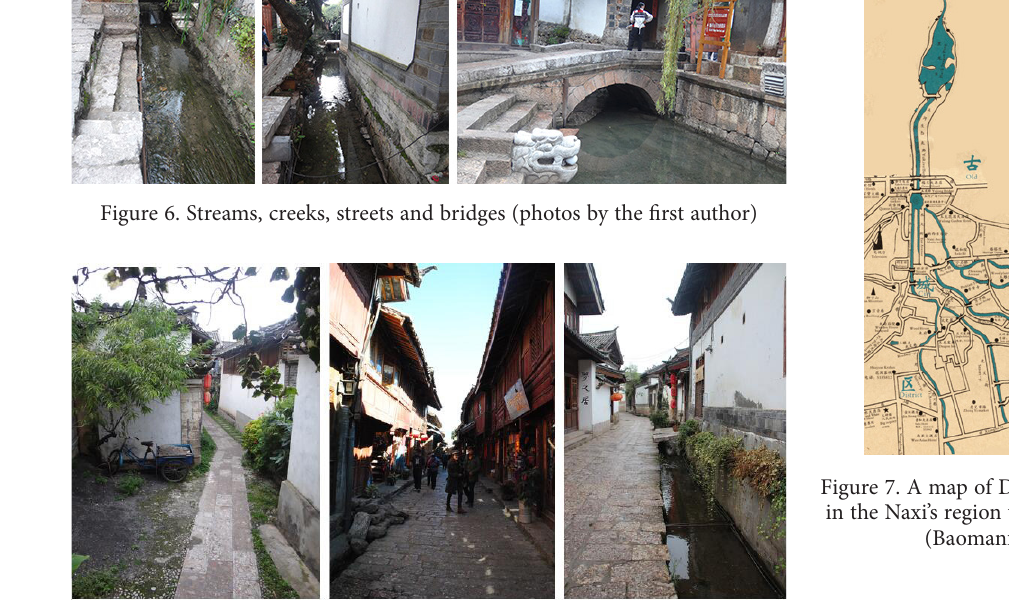
Figure 8. Circuitous streets and lanes (photos by the first author)